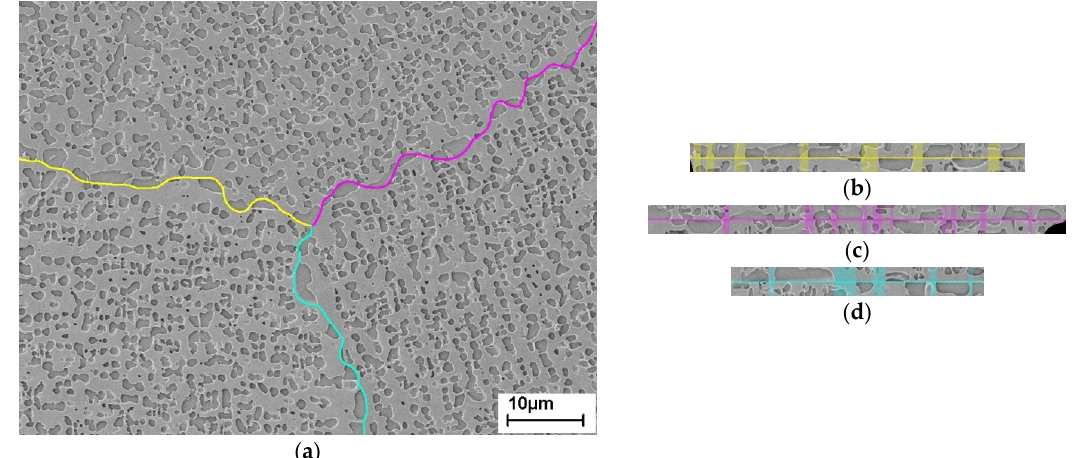
Figure 3. ( a ) Segmented lines on the grain boundaries of the aged material; ( b ) in ImageJ straightened grain boundary along the yellow, ( c ) magenta and ( d ) cyan segmented line with highlighted ligaments, i.e., those areas were on both sides of the grain boundary γ -matrix is present. The scale is valid for all images.